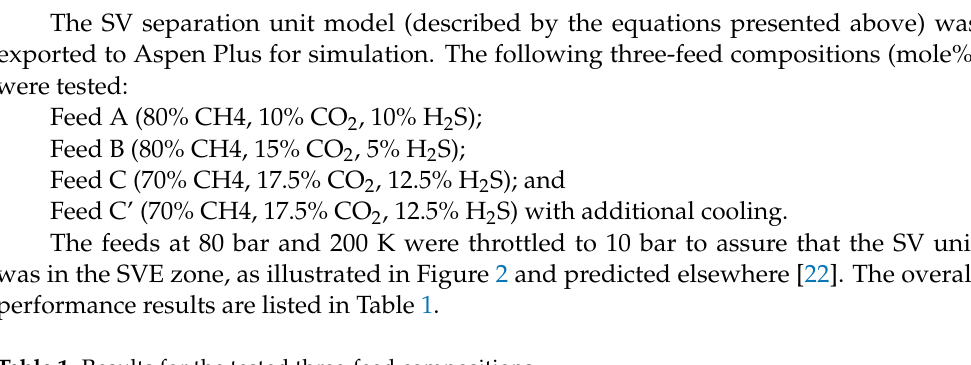
Table 1. Results for the tested three-feed compositions. Feed A B C C’ * T (K) after throttle valve 161.3 168.0 182.2